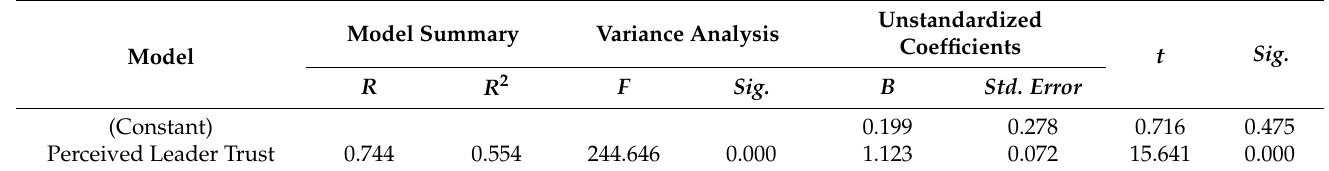
Table 13. Regression Analysis of Perceived Leader Trust on Employee Work